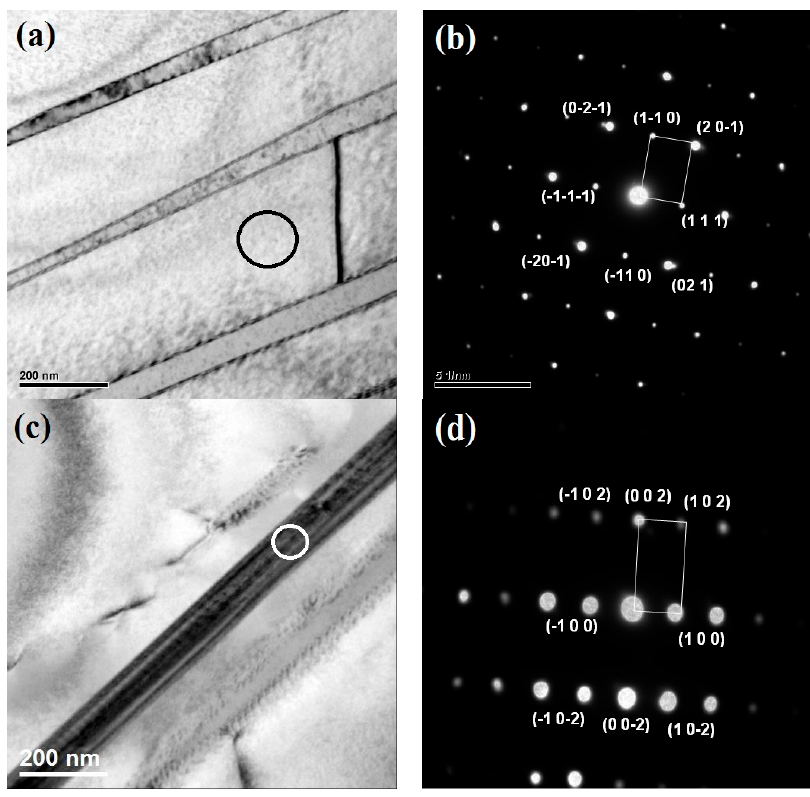
Figure 9. Cont. Figure 9. Cont.